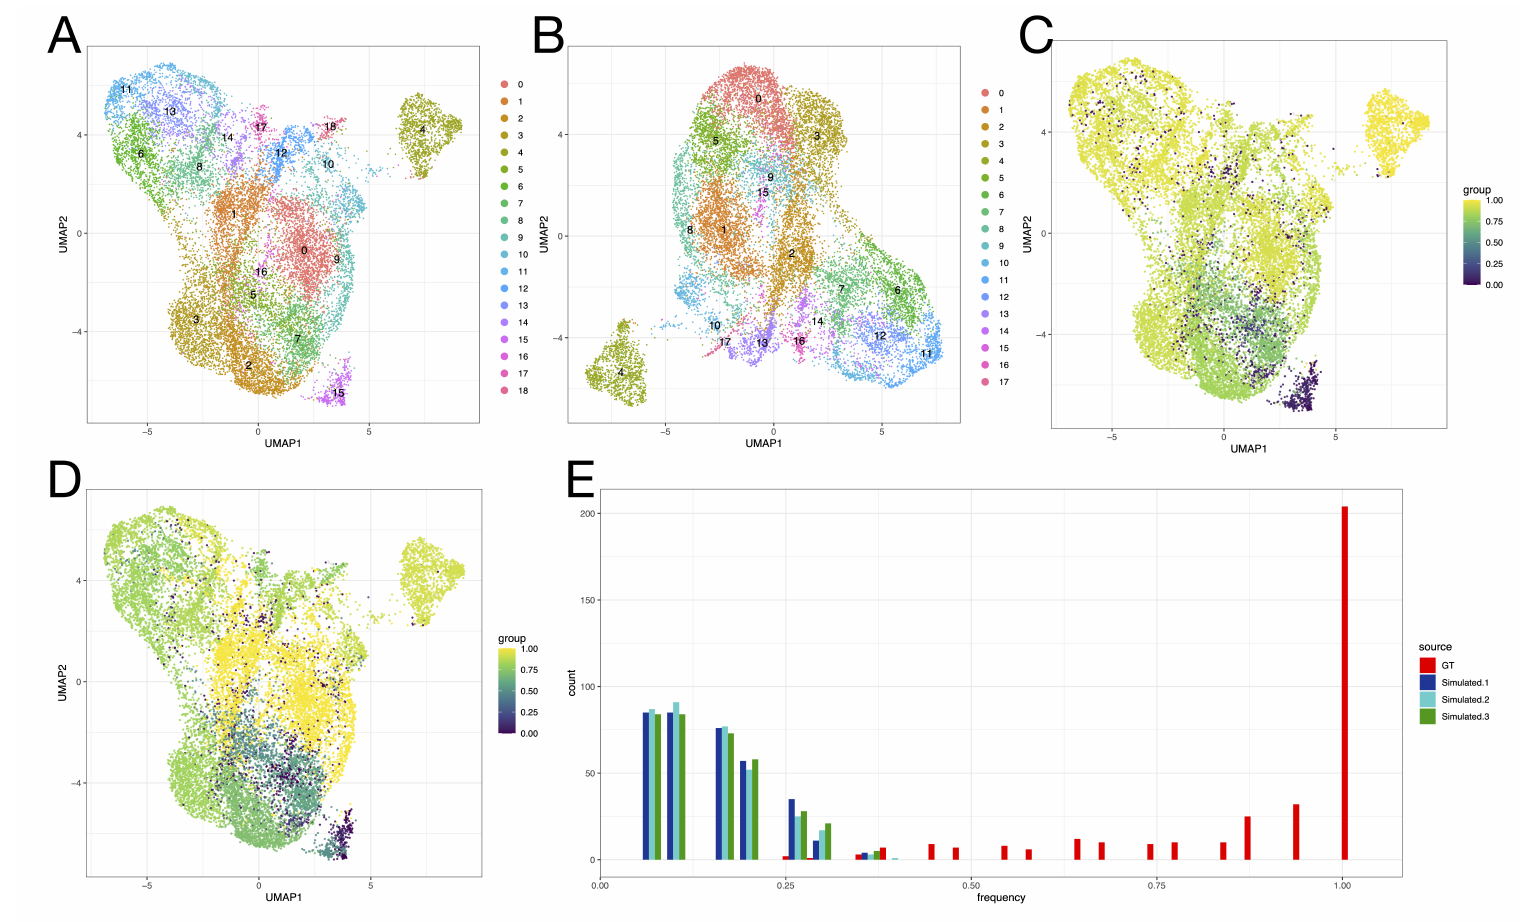
Figure 3. Lane splitting induces variability in clustering of P1 10x scRNA-seq data. ( A , B ): UMAP representations of GT ( A ) and S ( B ) samples, with colors indicating SLM clusters calculated on nearest-neighbor graphs; 19 clusters are found in GT and 18 in the S samples. ( C ). Element-centric clustering similarity, highlighted using the colour gradient, reveals differences between clusterings at the bottom of the UMAP, especially for the lower-right island of cells (vanishing island). ( D ). Jaccard similarity of cluster markers across GT and S clusterings suggests differences in cell types inferred from the data. ( E ). Fraction of within-island nearest neighbours for cells in the vanishing island in GT and 3 S samples. The island cells are no longer discrete from the larger body of cells in S